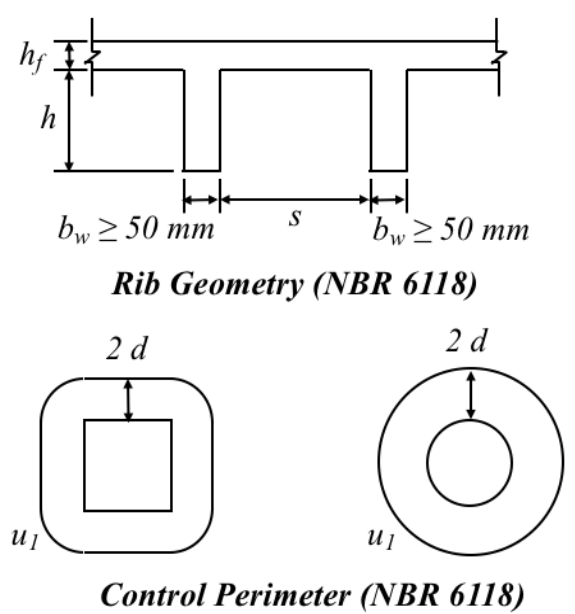
Figure 3. Rib geometry and control perimeter according to NBR 6118